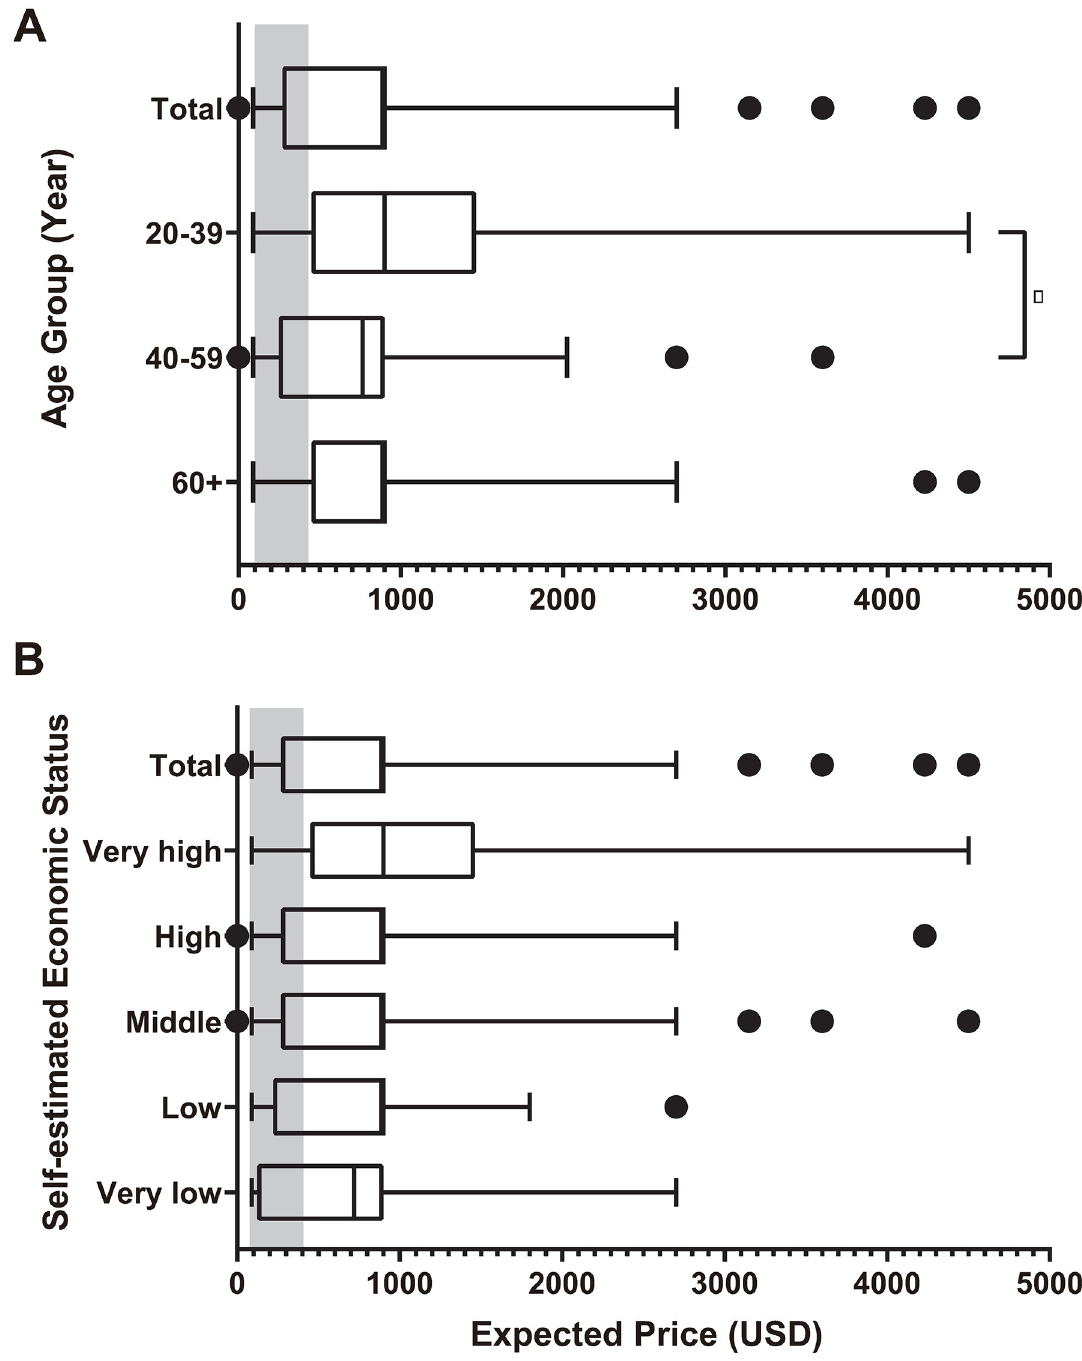
Fig 3. Expected price of personal sound amplification products (PSAPs). (A) Expected PSAP price according to age groups (20–39, 40–59, � 60-year-old). Mean expected price of the 20-39-year-old group (1123.2 USD, 95% CI, 772.1–1474.3) was significantly higher than that of the 40-59-year-old group (745.5 USD, 95% CI, 590.4–900.5, P < 0.026). (B) Expected PSAP price according to self- estimated economic status. Mean expected prices of the low group (724.3 USD, 95% CI, 797.5–1141.1) and the very low group (742.6 USD, 95% CI, 344.3–1140.8) were lower than that of the very high group (1201.4 USD, 95% CI, 869.4–1533.4). A box and whisker plot shows summary of a set of data: Maximum, 75 percentile, median, 25 percentile and minimum. Grey area indicates real market price of PSAPs. USD, United States